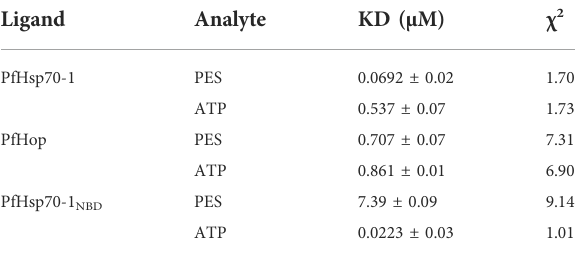
K D , equilibrium constant, X 2 values indicate the goodness of fi t for SPR, sensorgrams. Each parameter is the mean for three independent experiments, each performed in triplicate and standard errors of the mean are indicated.